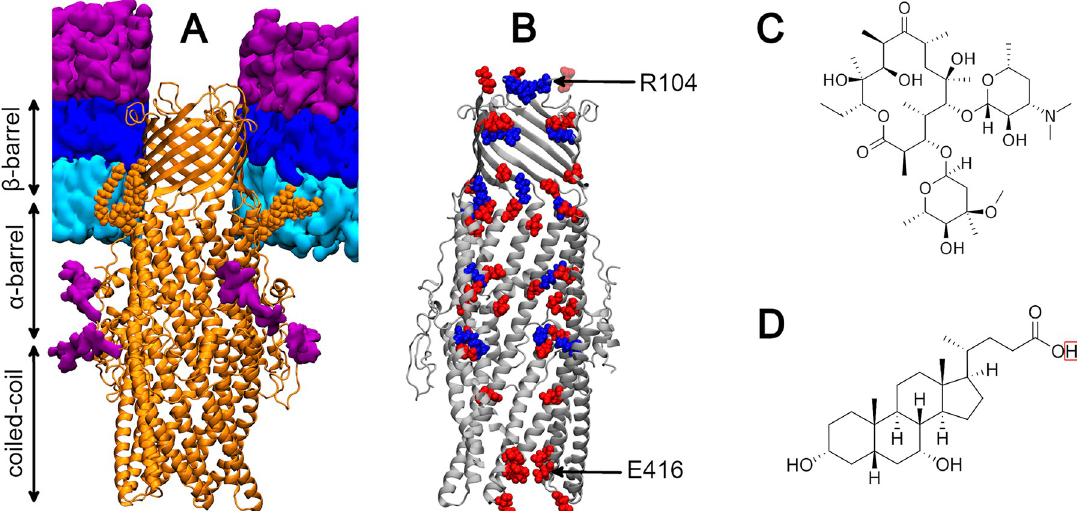
Fig 1. Protein and substrate structures. (A) CmeC embedded in a model C. jejuni outer membrane. CmeC shown in orange New Cartoon representation, with N-terminal lipidation shown in orange van der Waals (VDW); phospholipids shown as cyan surface; Lipid A moieties of LOS shown as a dark blue surface; and LOS oligosaccharides and N-glycans shown as a purple surface. The β -barrel and top of the α -barrel are embedded in the hydrophobic membrane core. (B) Cutaway of the x-ray crystallographic structure of CmeC (grey New Cartoon), with acidic and basic residues that line the central channel shown in red and blue VDW representation respectively. Residues identified as constrictions in the X-ray crystal structure (R104 and E416) labelled. (C) Structure of the macrolide antibiotic erythromycin. (D) Structure of the bile acid chenodeoxycholic acid (CDCA). The proton highlighted by the red box is removed in solution to yield a carboxylate group.